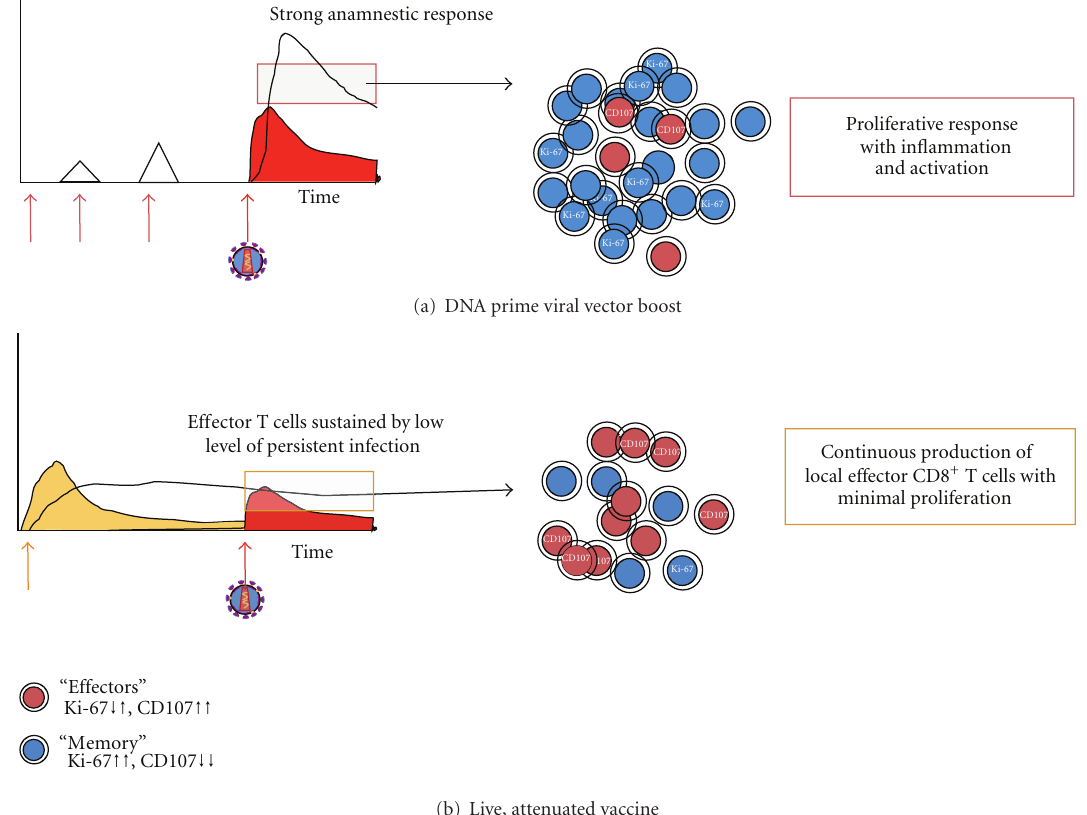
Figure 1: Hypothetical model for distinct CTL response depending on the immunization strategy. (a) and (b) graphs depict both CTL response and viremia ( y -axes) over time ( x -axes). Time ( x -axes) includes the period of immunization and the period of infection after pathogenic challenge (bright red arrow with virus illustration). A DNA prime viral vector boost strategy (a) induces blips of CTL response after each immunization (with an associated memory response). Upon pathogenic challenge, this strategy generates a strong anamnestic response that has greater memory than e ff ector CD8 + T-cell component, which will enhance the proliferative response and the associated inflammation and immune activation. In contrast, a live, attenuated vaccine (b) generates persistent CTL response coupled to vaccine virus replication. The continuous production of e ff ector CD8 + T cells is sustained by low level of persistent infection in di ff erent tissues, including the mucosa. At the time of virus challenge, the presence of local e ff ector CTLs is capable of controlling the initial focus of viral replication with minimal proliferation, since these cells have more cytotoxic than proliferative